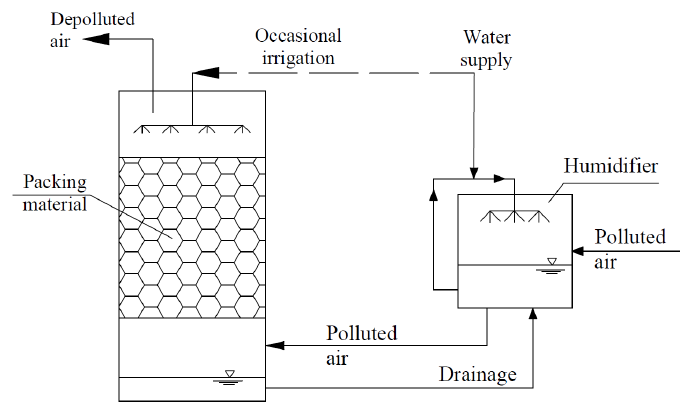
Figure 2. Closed-type biofilter with inlet gas humidification chamber.